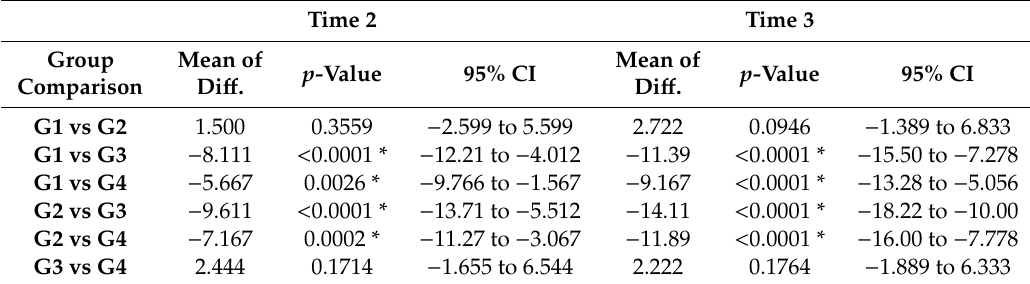
Table 2. Bonferroni’s multiple comparison test to compare the ISQ values between the two times with statistically significant difference (at 15 and 30 days).